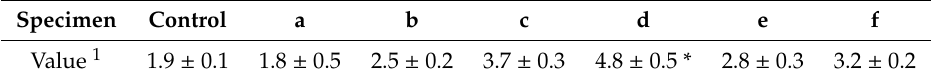
Table 2. Composites’ mechanical strength